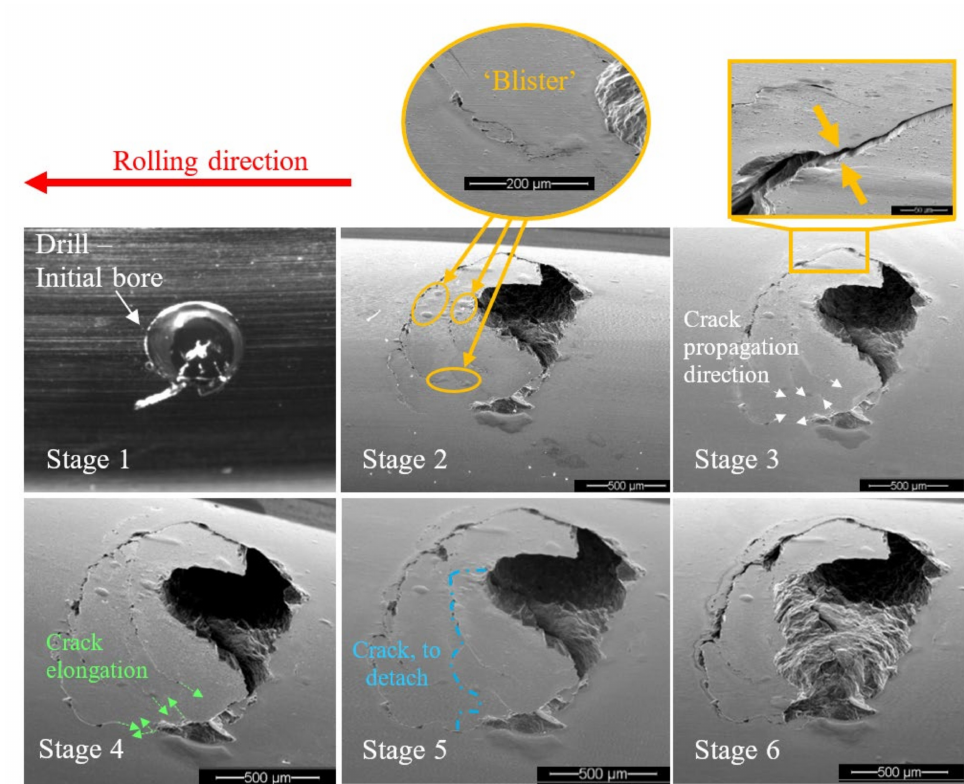
Figure 10. Images from the disassembly and reassembly test. The net crack propagation direction is marked by white arrows in Stage 3. The crack elongation from Stage 3 to Stage 4 is marked by green arrows in Stage 4. “Blisters” at the tip of cracks appear to delay the crack propagation on the surface. The blue dashed line represents the fragment that is about to detach from the raceway between Stages 5 and 6.